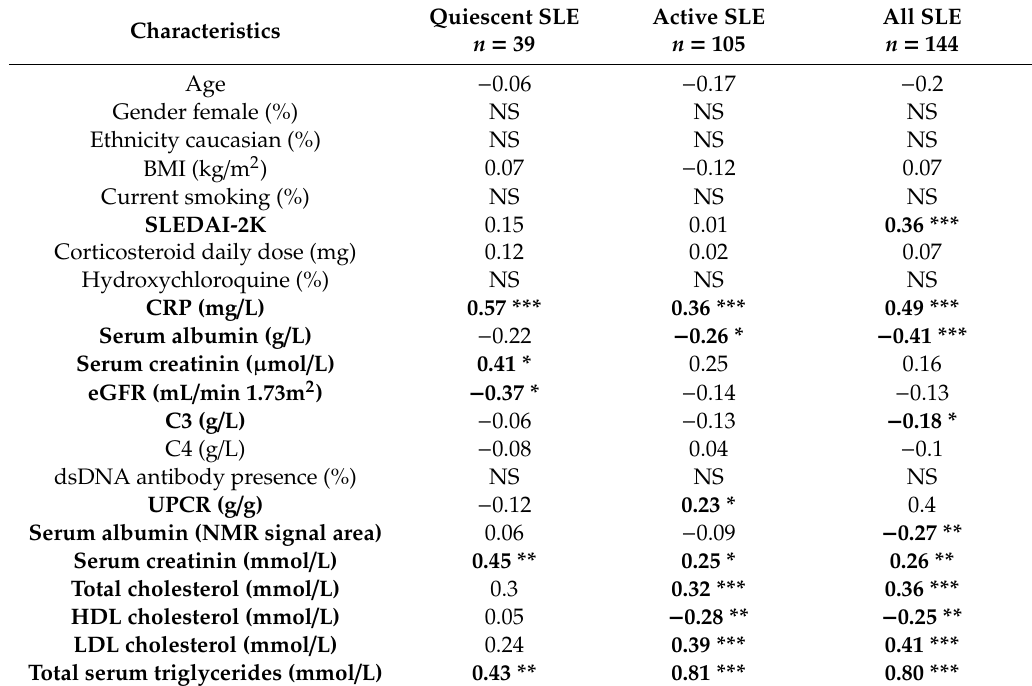
Table 2. GlycA associations in SLE patient